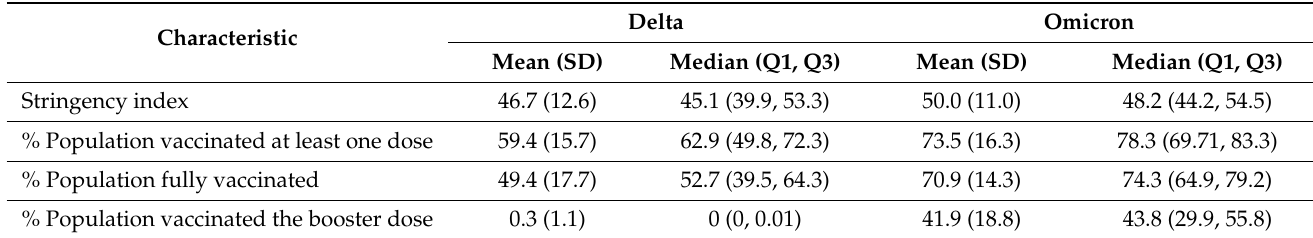
Table 2. Vaccine and stringency index characteristics between two